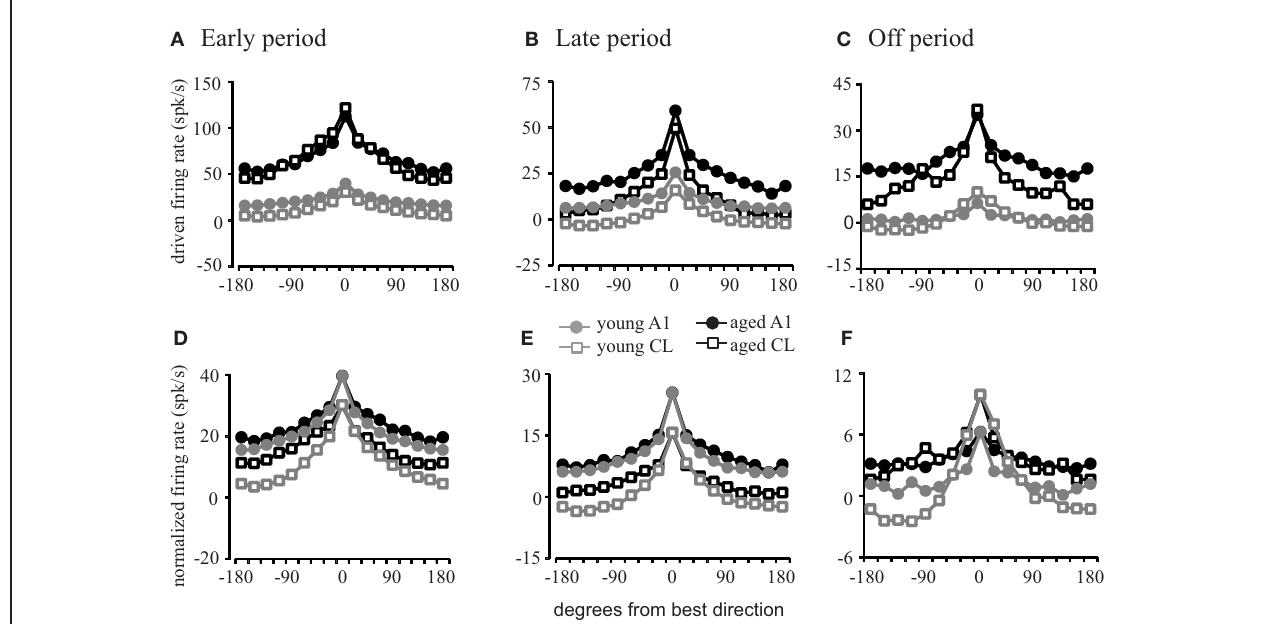
FIGURE 4 | Firing rates as a function of stimulus location. Population firing rate curves relative to the best direction of each cell. (A–C) Show the absolute firing rate; (D–F) show rates normalized to the best direction of the young animals. Response profiles in the early (A,D) , late (B,E) , and off (C,F) periods are shown. Aged animals have a much greater driven